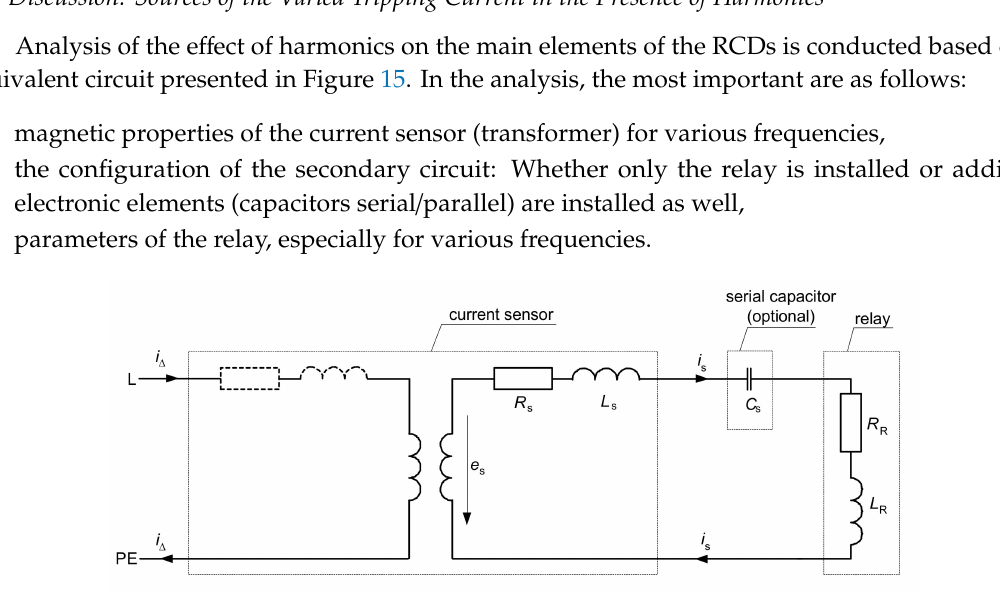
Figure 15. Equivalent circuit of the RCD; i ∆ —residual (primary) current, i s —secondary current, e s